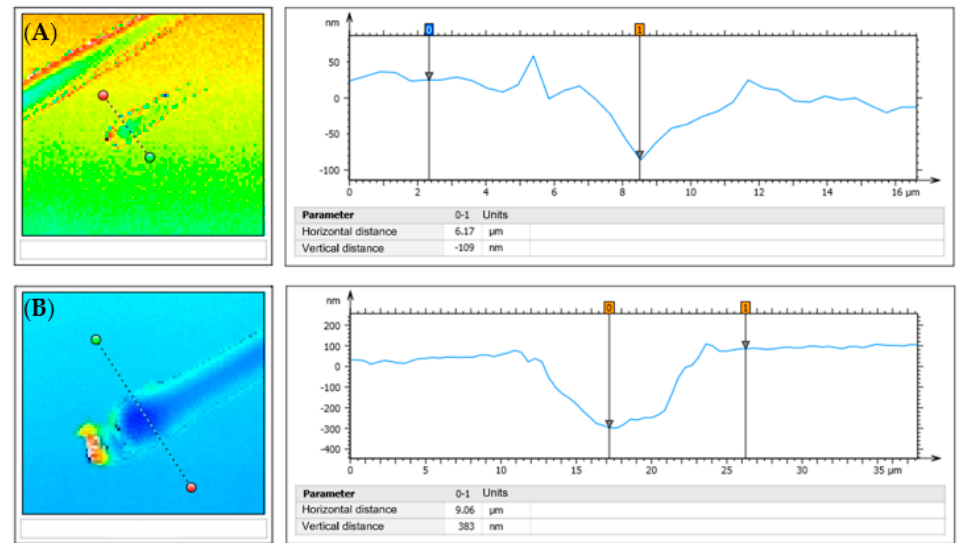
Figure 8. LSM measurements of penetration depths for ( A ) contact force 1 and ( B ) contact force 2. The left images show the complete LSM scans, while the right images show the cross-sections indicated in the left images.